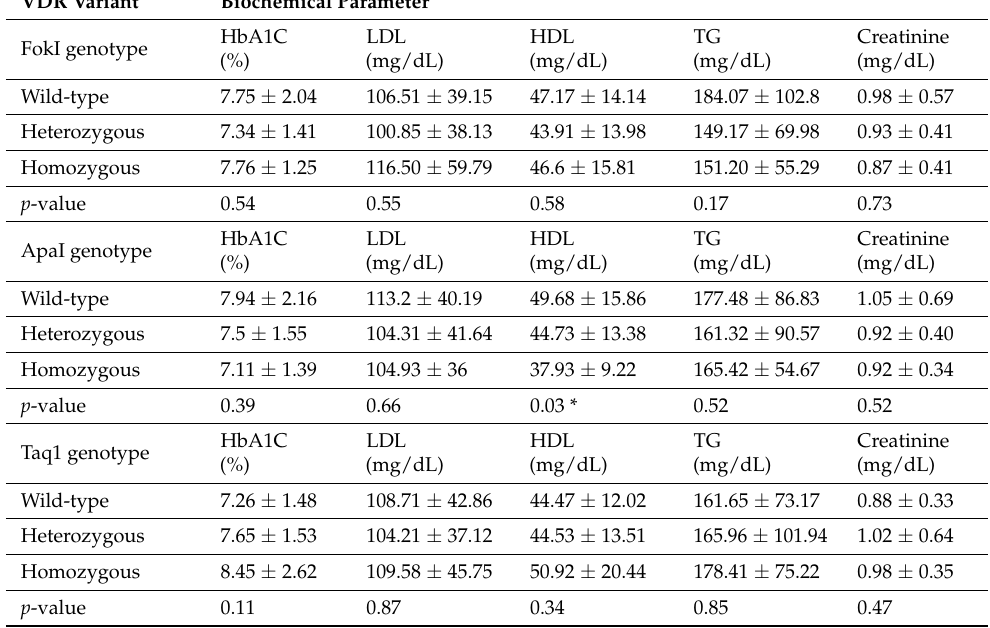
Table 5. Associations of VDR FokI , ApaI , Taq1 , and BsmI variants with the biochemical parameters of T2DM patients. VDR Variant